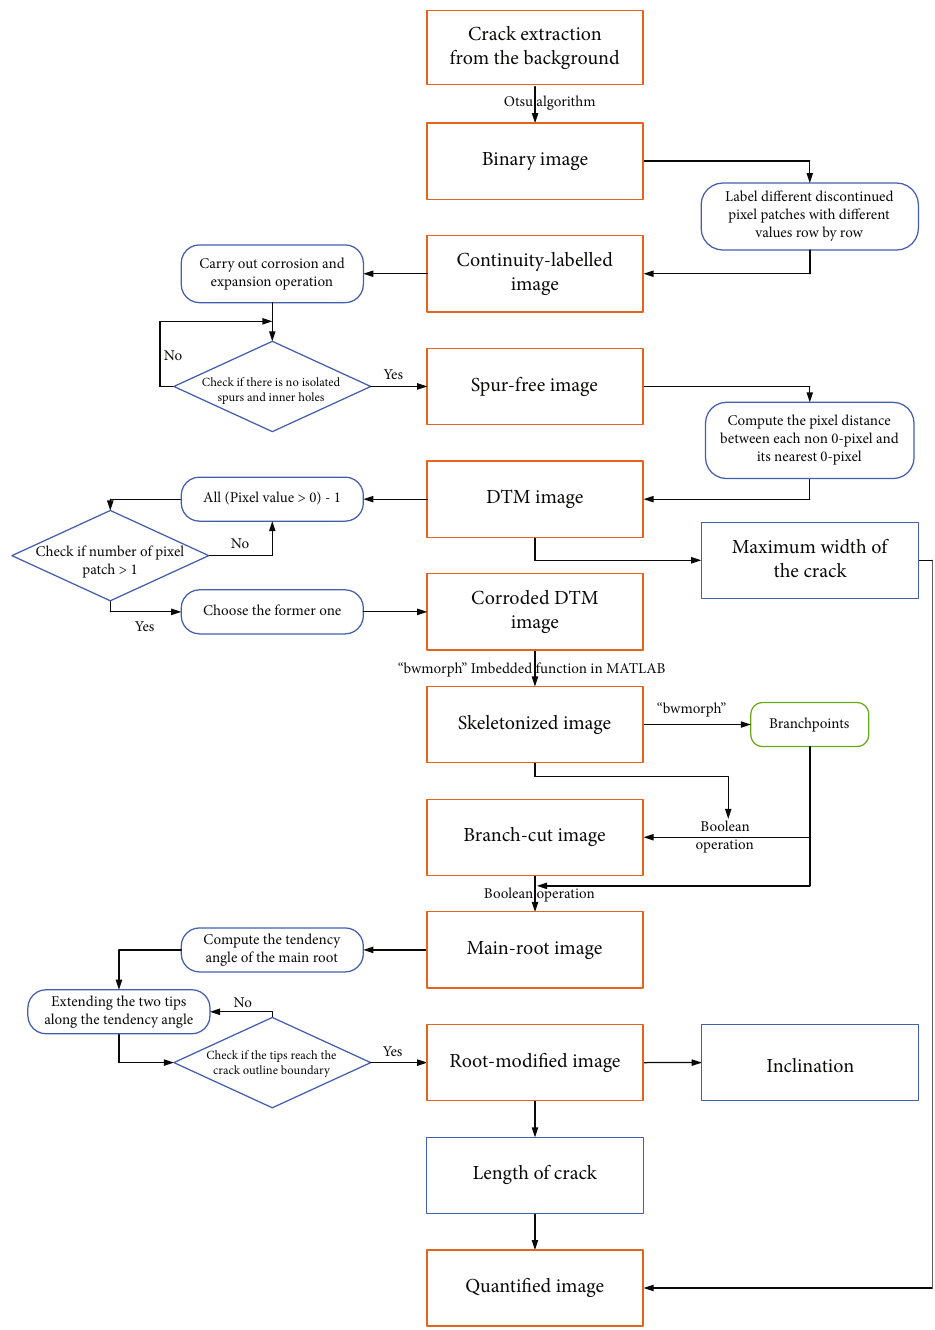
Figure 11: Crack quanti fi cation algorithm fl